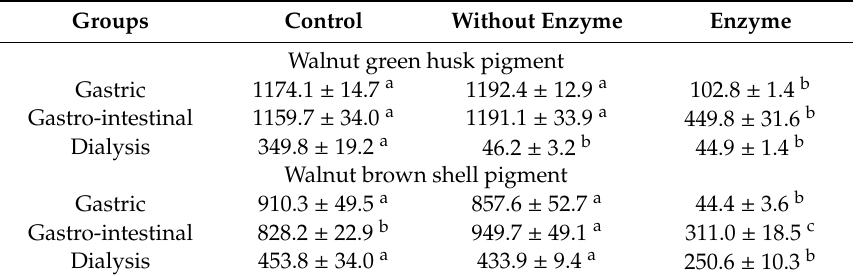
Table 1. The 2,2 (cid:48) -azino-bis(3-ethylbenzothiazoline-6-sulfonic acid) (ABTS) radical scavenging ability of walnut green husk and brown shell pigment subjected to simulated in vitro digestion and dialysis ( µ mol TE / L).